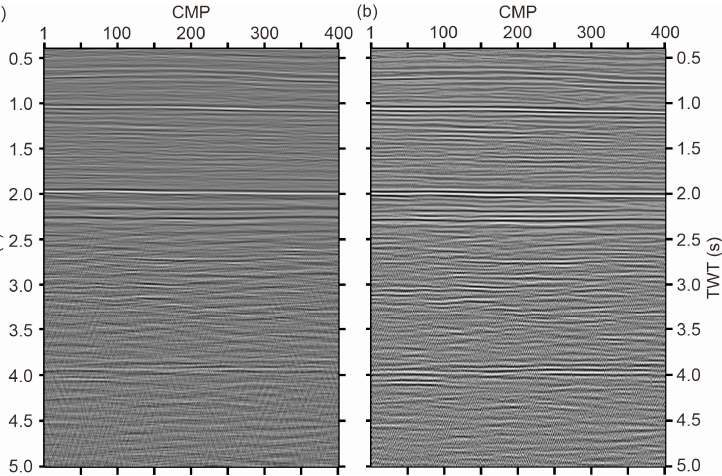
Figure 11. A fragment of a stacked data section (Figure 10a) after corrections by using ( a ) stabilized inverse- Q filtering [1] and ( b ) ITD.